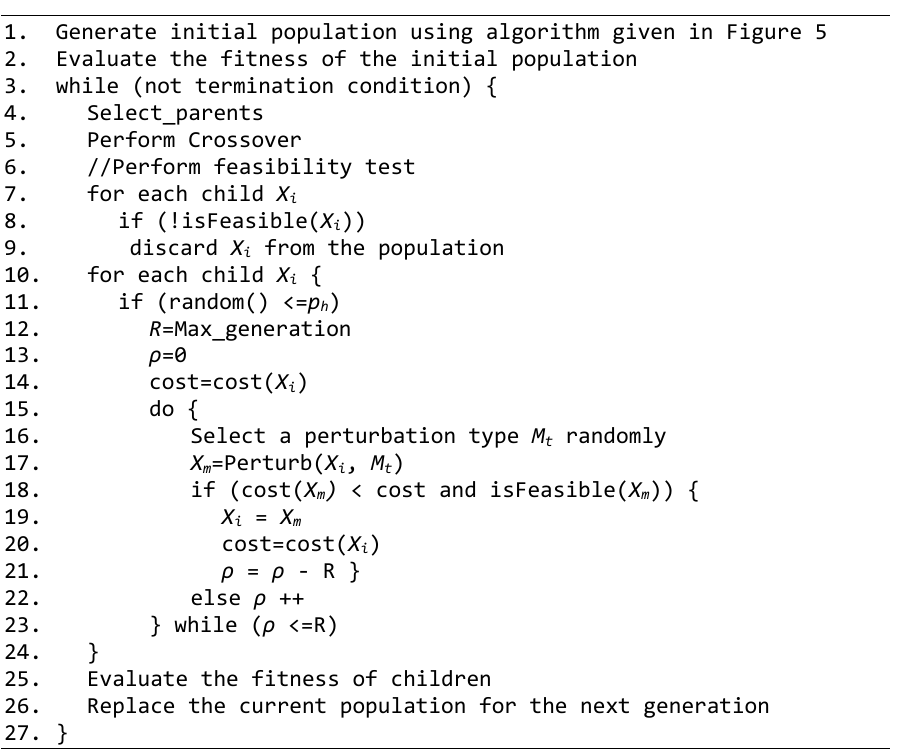
Figure 2. Genetic algorithm with adaptive selection of crossover and mutation.